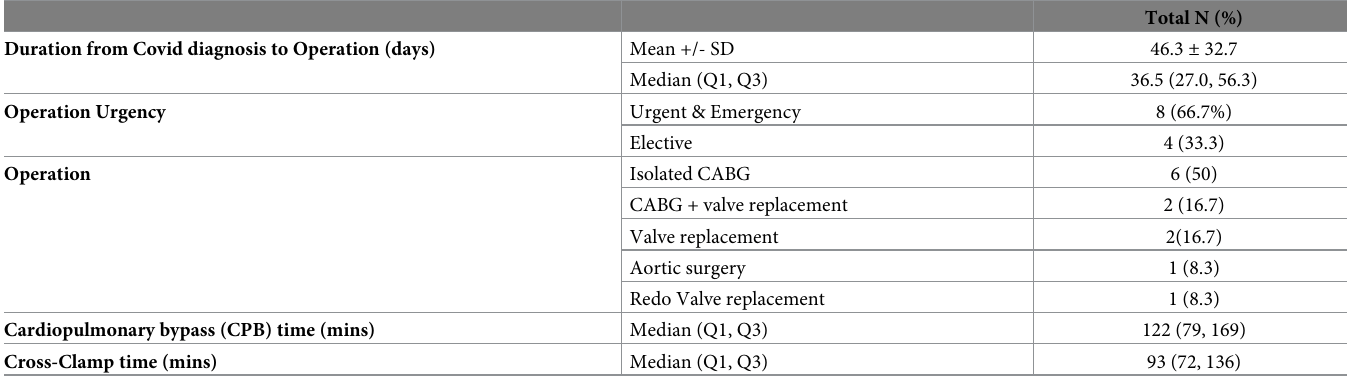
Table 2. Operation and